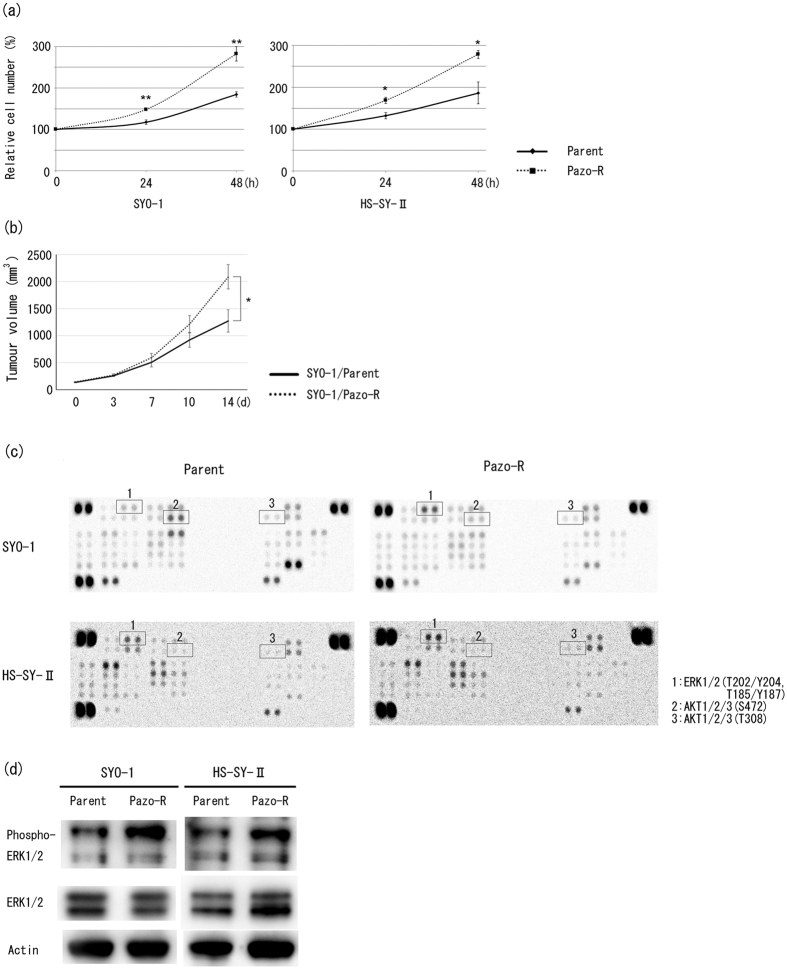
Phosphorylation profiles of cell signalling molecules in each clone.(a) SS clones were incubated for 48 hours. The relative number of viable cells was evaluated by CellTiter-GloTM Luminescent Cell Viability Assay. Values represent mean ± S.D. *P < 0.05; **P < 0.01, vs parental clones. (b) Tumourigenicity of SYO-1 parental and pazopanib-resistant clones. *P < 0.05, vs SYO-1 parental clone. (c) Multiplex analysis of the phosphorylation profile of the cell signalling molecules in SS clones. (d) Activated phosphorylation of ERK1/2 in pazopanib-resistant clones was confirmed by Western blot analysis using anti-ERK1/2 and anti-phospho-ERK1/2 antibodies. Pazo-R represents pazopanib-resistant clone.